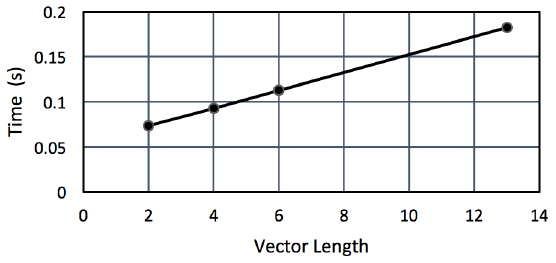
Figure 7. SVM classification times on a JN5148 node with 100 vectors.